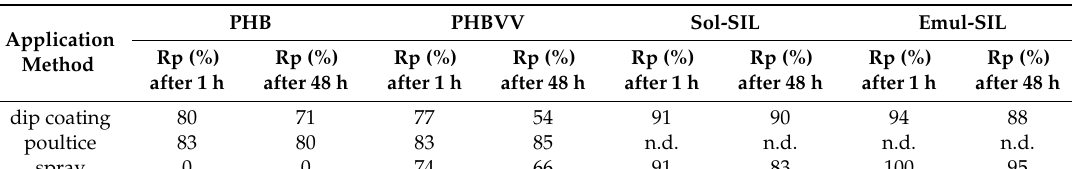
Table 13. Mean ratio of protection of the treatments on sandstone after the artificial ageing (n.d.: not determined).